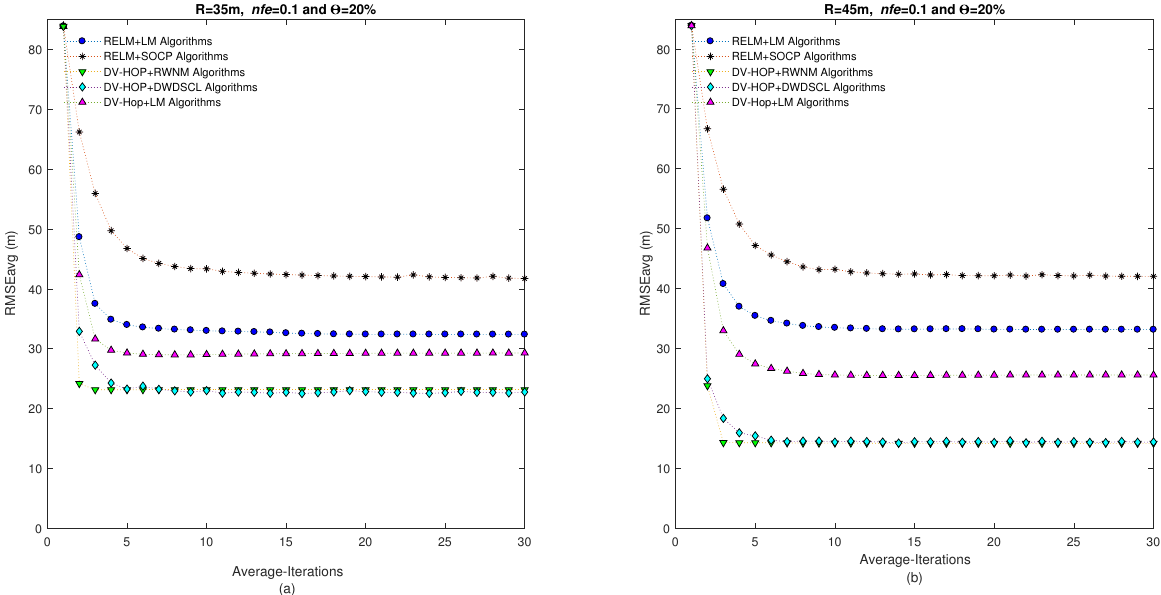
Figure 7. RMSEavg vs. Iterations of algorithms using Θ = 20% and nfe = 0.1 considering the average of 10 independent isotropic networks. ( a ) Corresponds to R = 35 m and ( b ) R = 45